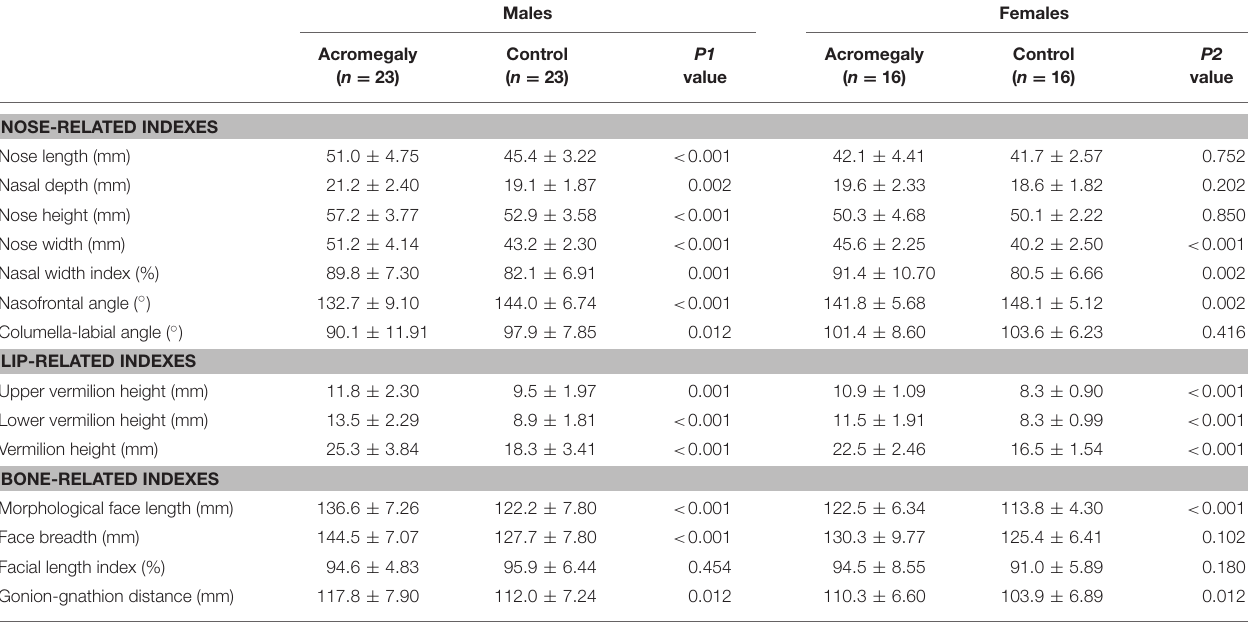
TABLE 3 | Gender-specific facial features in